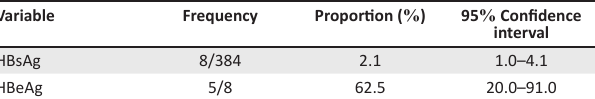
TABLE 2: Overall prevalence of HBsAg and HBeAg positivity among participants attending antenatal at Kyazanga Health Centre IV, South Western Uganda, between April 2021 and June 2021.